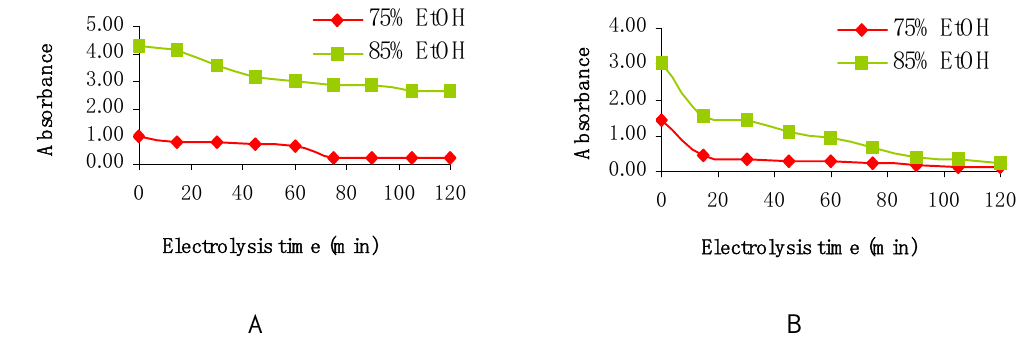
Figure 5. Plots of absorbance at 665 nm and electrolysis time for each ethanol concentration of extracted chlorophyll solution; A: with aluminium as electrodes, B: with iron as electrodes; ♦ , 75% ethanol; ■ , 80% ethanol